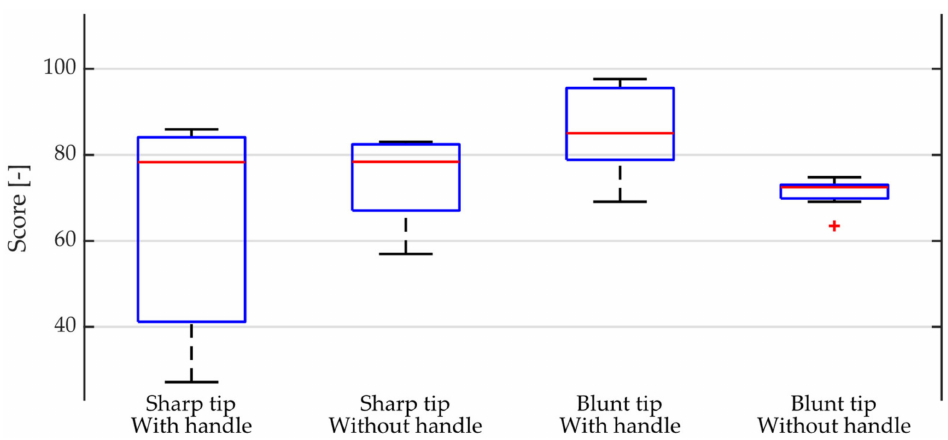
Figure 15. Boxplot of score distribution for each combination of tip and